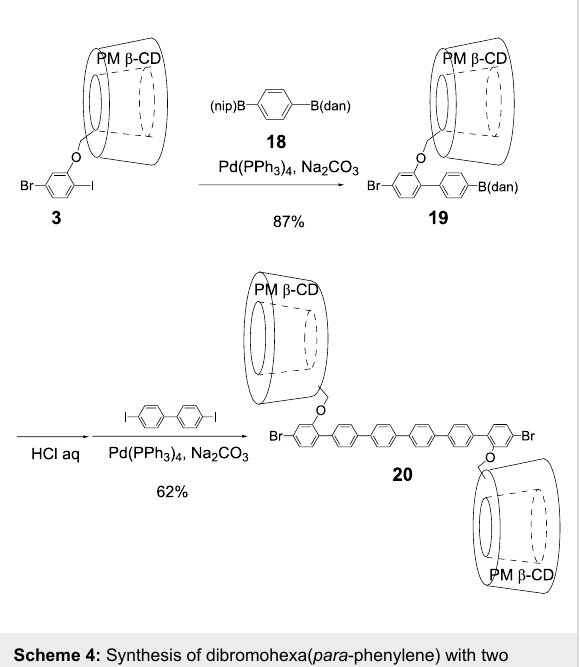
Scheme 4: Synthesis of dibromohexa( para -phenylene) with two PMCDs 20 .